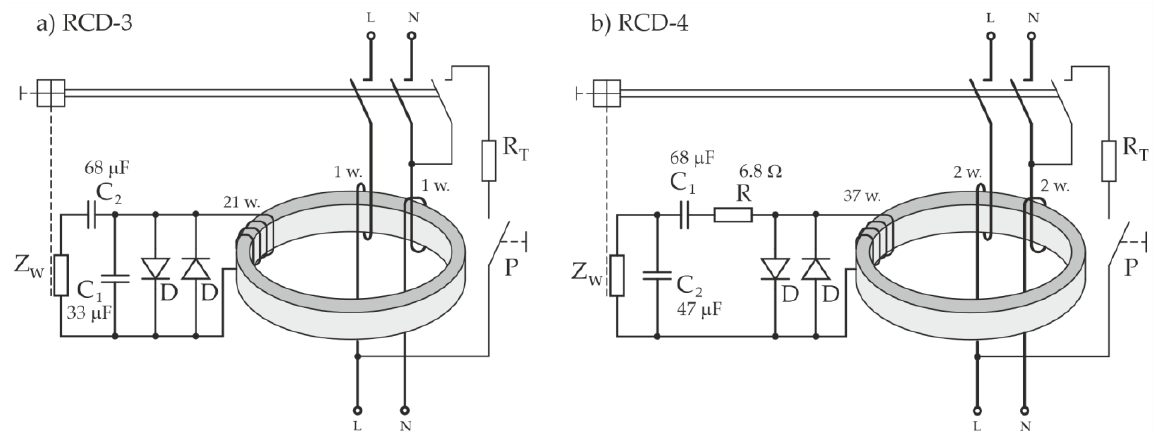
Figure 7. Diagram of the internal structure of the tested circuit breakers: ( a ) RCD-1 and ( b ) RCD-2.